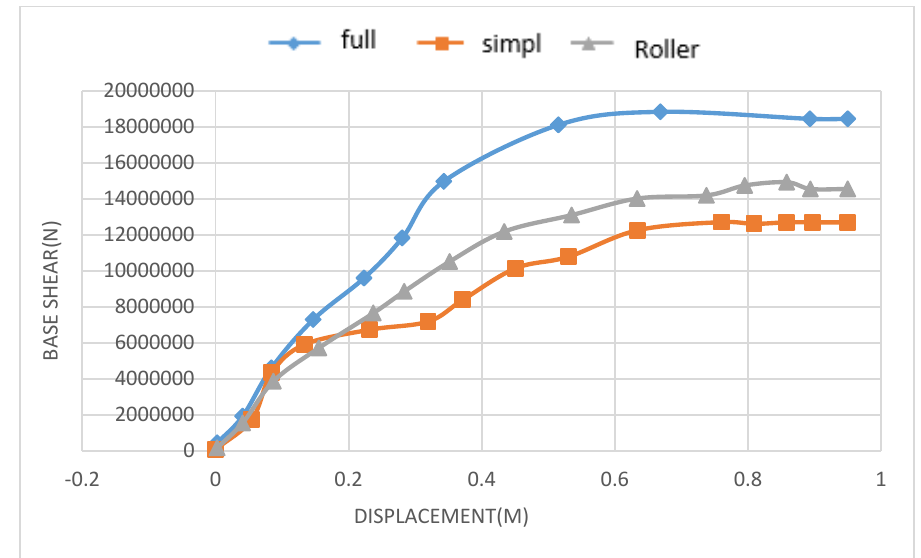
Fig. 15. 5 spans bridge with base height 6 meters in longitudinal direction.